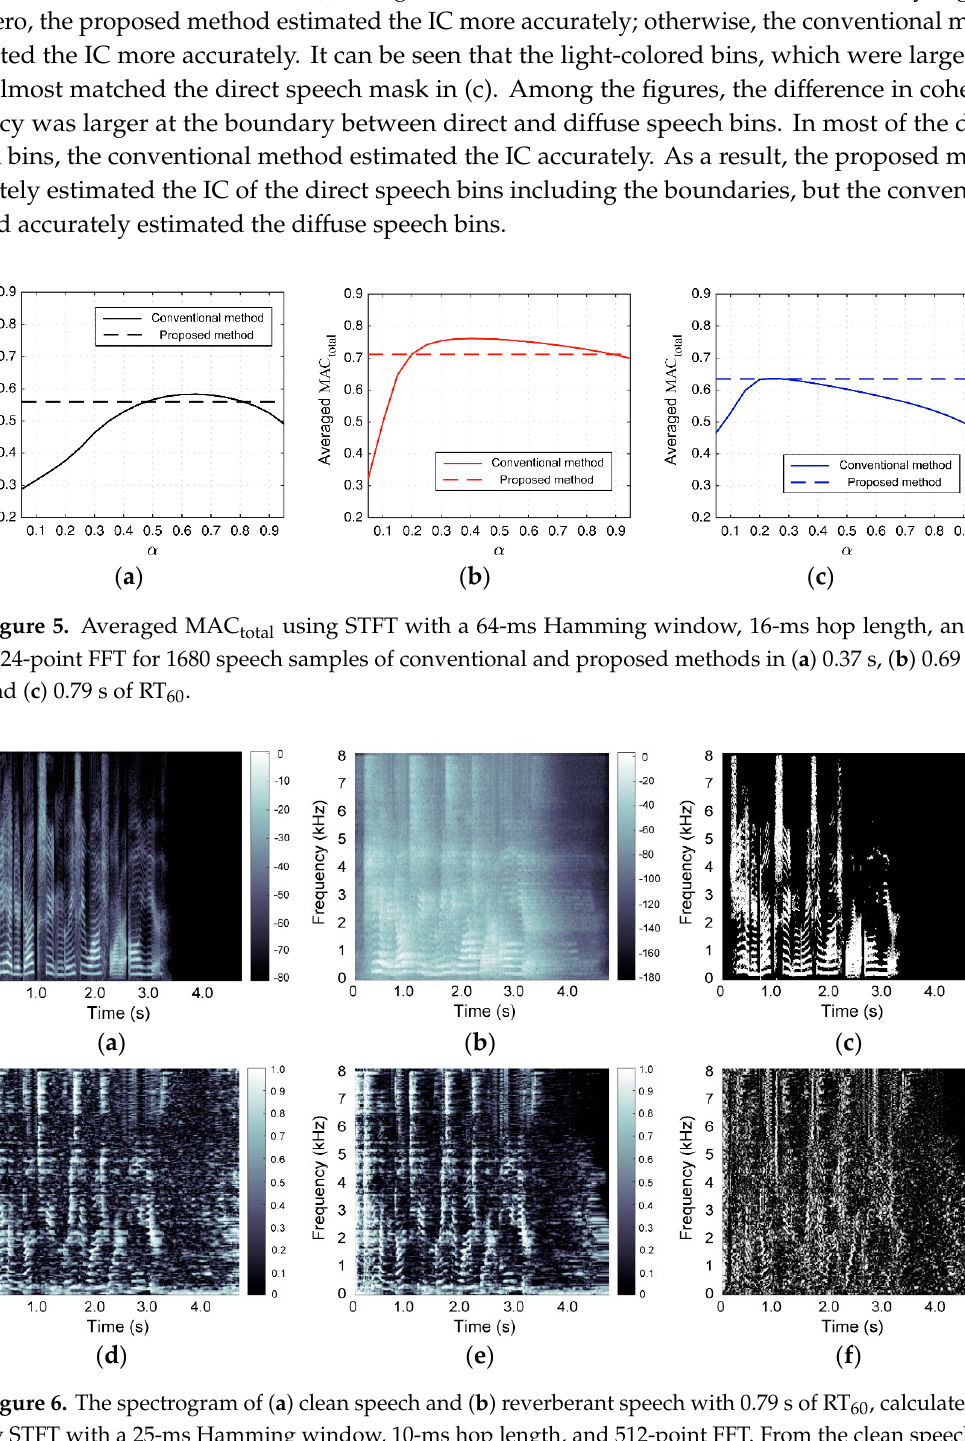
Figure 6. The spectrogram of ( a ) clean speech and ( b ) reverberant speech with 0.79 s of RT 60 , calculated by STFT with a 25-ms Hamming window, 10-ms hop length, and 512-point FFT. From the clean speech, ( c ) the binary mask of direct speech was determined. The interaural coherence (IC) of time–frequency bins was estimated by ( d ) the proposed method and ( e ) the conventional method with optimal parameters. ( f ) The difference in coherence accuracy between each